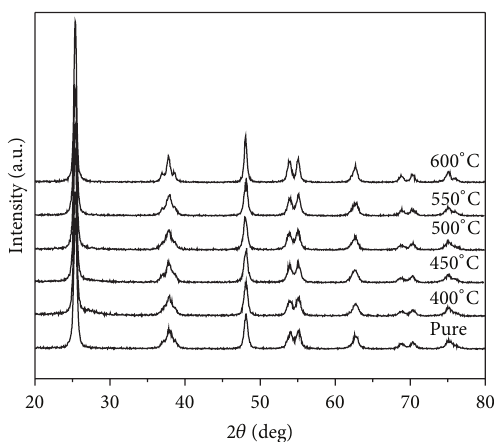
Figure 1: XRD patterns of the C 3 N 4 /TiO 2 nanocomposites obtained under different